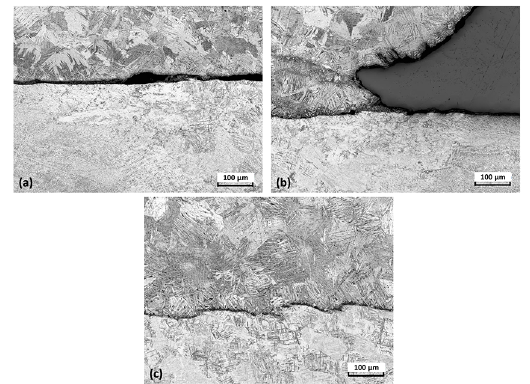
Figure 5. The coating presented (a) a lack of bonding on the AS, (b) no unbonded region on RS and (c) good bonding integrity away from the edges of the coating (4000 rpm)